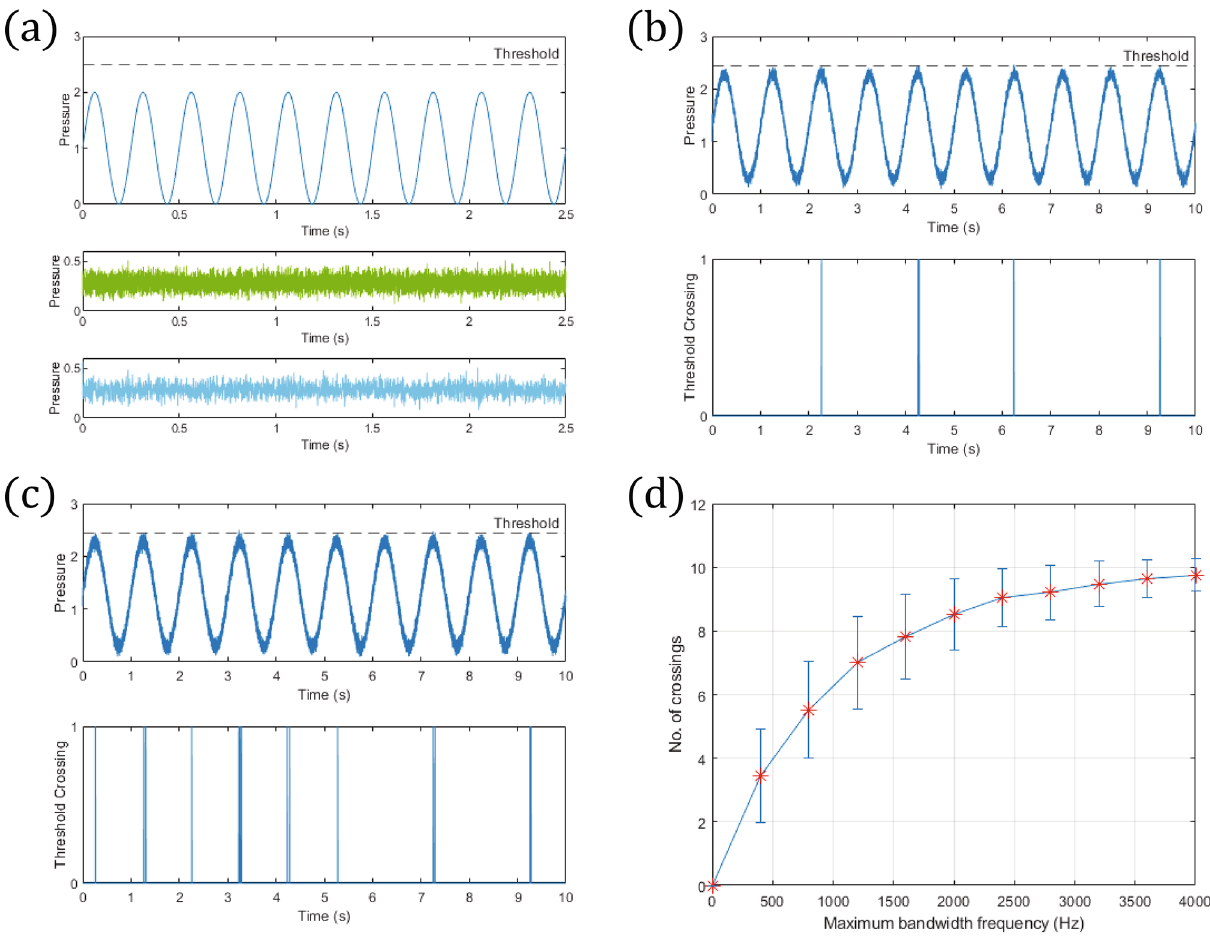
Figure 4. ( a ) Sub-threshold pressure stimulus (4 Hz sinusoid) and the chosen threshold (dotted line). A wide (maximum frequency 1600 Hz) and narrow (maximum frequency 400 Hz) bandwidth Gaussian noise is plotted below the sinusoid in green and blue, respectively. ( b , c ) The resultant pressure after the narrow and wide bandwidth Gaussian noise in ( a ) were added to the sub-threshold pressure, respectively. When the threshold is crossed by the resultant pressure, a spike of value 1 is plotted. ( d ) The number of crossings (over 10 cycles) versus the maximum bandwidth frequency of the noise. The plotted number of crossings for each maximum frequency is the mean of the number of crossings for 1000 realizations of the noise. The error bar is the corresponding standard